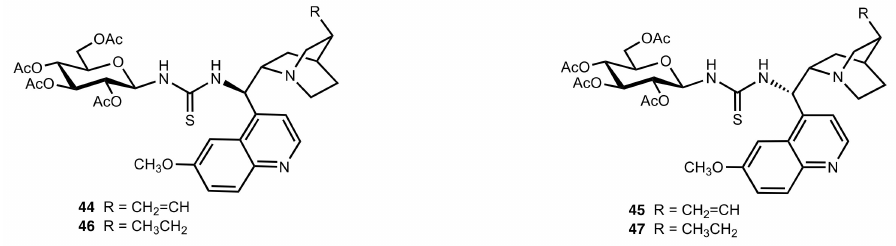
Figure 5. Sugar thioureas containing quinine, quinidine, dihydroquinine and dihydroquinidine. Preliminary experiments allowed establishing that 44 gave better results compared to the three other organocatalysts. In isopropanol as the solvent, the catalyst 44 (5 mol%) led, after 7 h at 5 ◦ C, to the ( R )-configured adducts in excellent yield (85–99%) and enantiose- lectivity (85–99% ee ) starting from a variety of nitrostyrenes and even a n -butyl derivative (Scheme